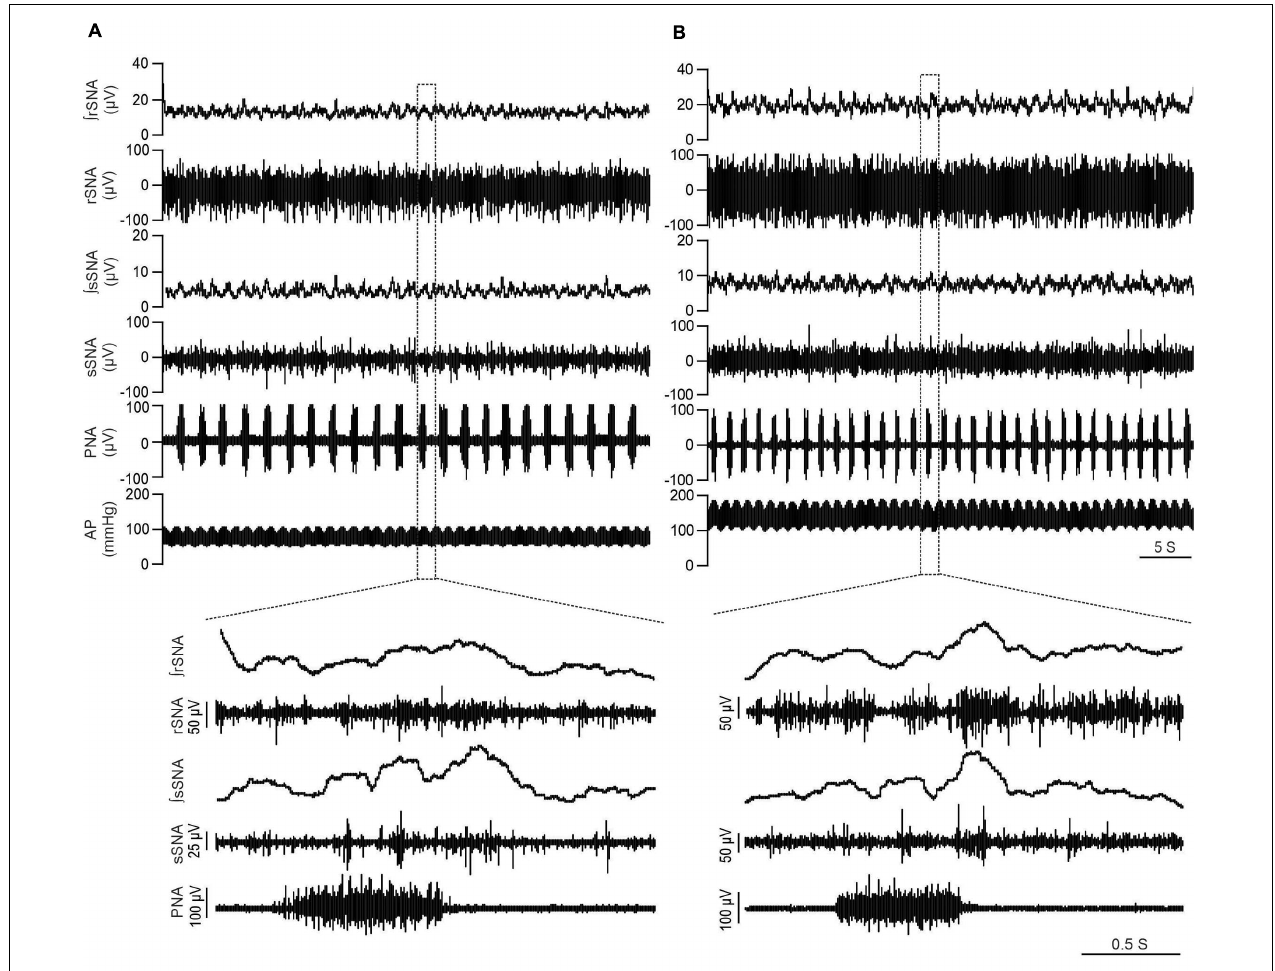
FIGURE 1 | LPK rats exhibit higher SNA and BP in baseline recordings. Physiological recordings under urethane anesthesia representing raw and integrated renal sympathetic nerve activity (rSNA and R rSNA), splanchnic sympathetic nerve activity (sSNA and R sSNA), phrenic nerve activity (PNA) and arterial pressure (AP) in a 12-week-old Lewis rat (A) and 12-week-old LPK rat (B) . Note the higher rSNA, sSNA, and arterial pressure in the LPK in comparison to Lewis rats. Bottom panels illustrate Enlarged traces of one respiratory cycle with corresponding splanchnic and renal SNA.